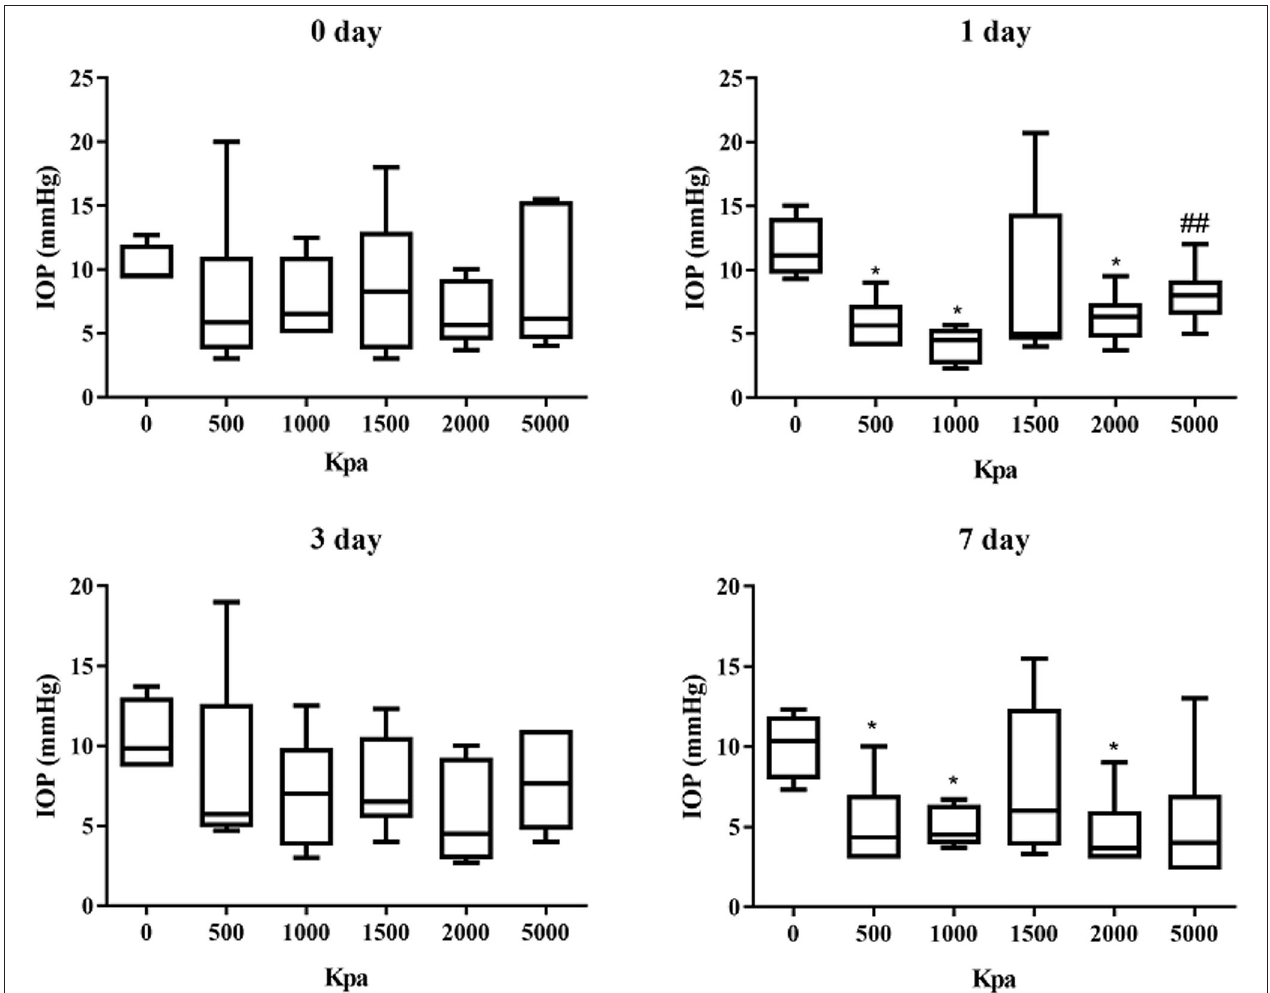
FIGURE 11 | Graphs of changes of IOP with gas pressure detected at the same time point. *Means P < 0.05 compared with the blank control group. ##means compared to the 1000 Kpa, the decrease of IOP in eyes exposed to 5000 Kpa was statistically significant with p <